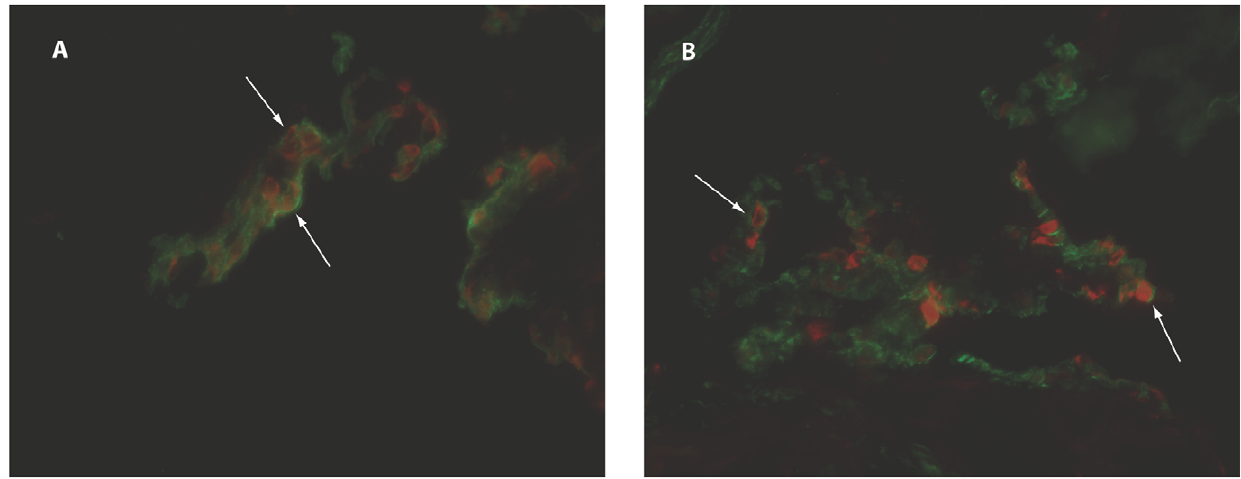
Figure 5. MPGES1 expression in synovial lining fibroblasts before and 16 weeks after initiation of rituximab therapy. Double immunofluorescence pictures show the presence of MPGES1 (red) expression in CD55 positive fibroblasts (green) in the rheumatoid tissue before